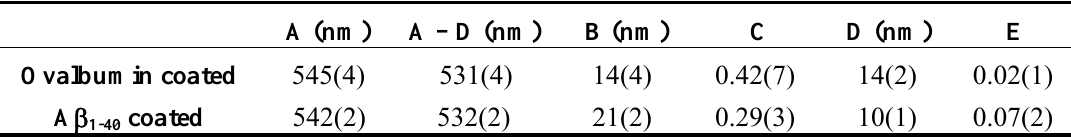
Table 1. The list of extracted parameters (A, B, C, D and E) with the use of Equation 3 for ovalbumin or A  coated 20 nm gold 1-40